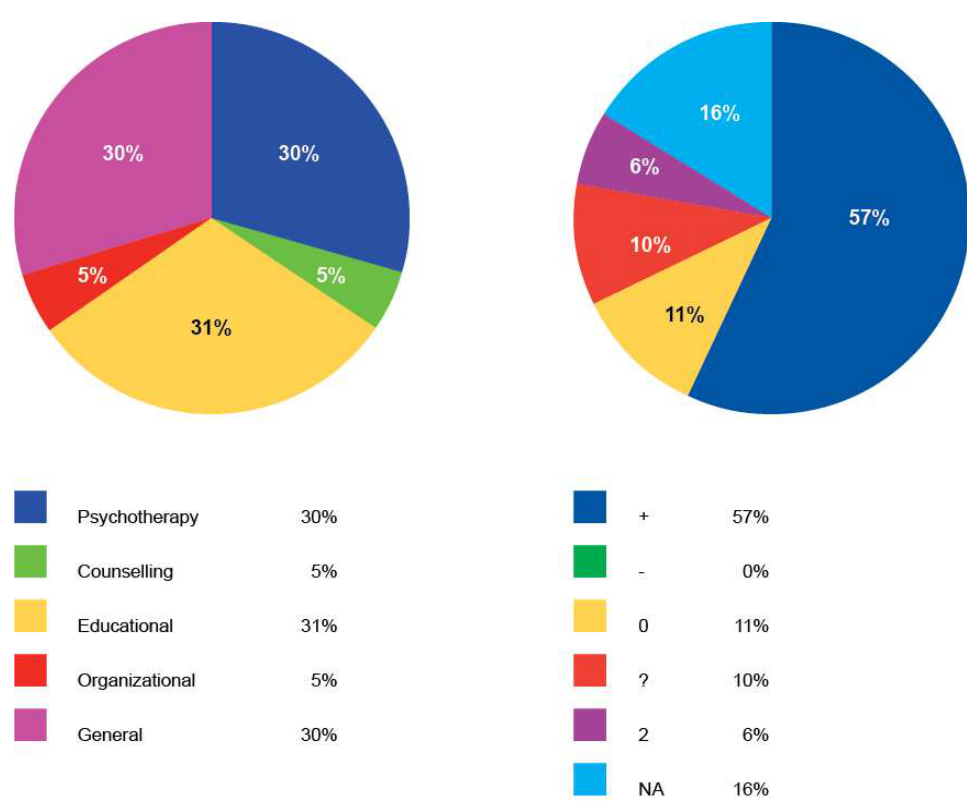
Figure 3. The Psychoterapy List – Ratings of 88